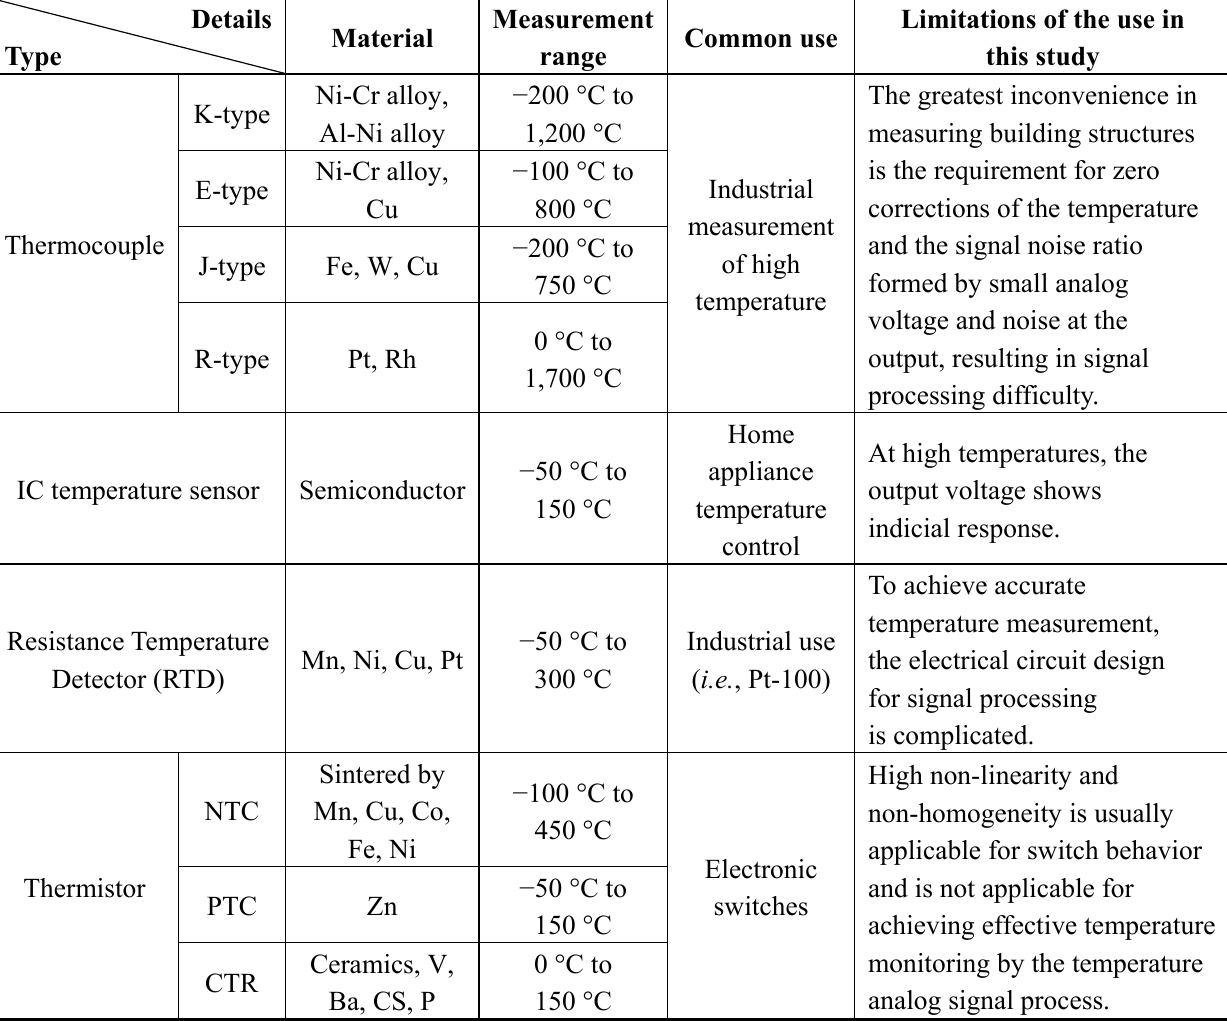
Table 1. Limitations of using common temperature sensing